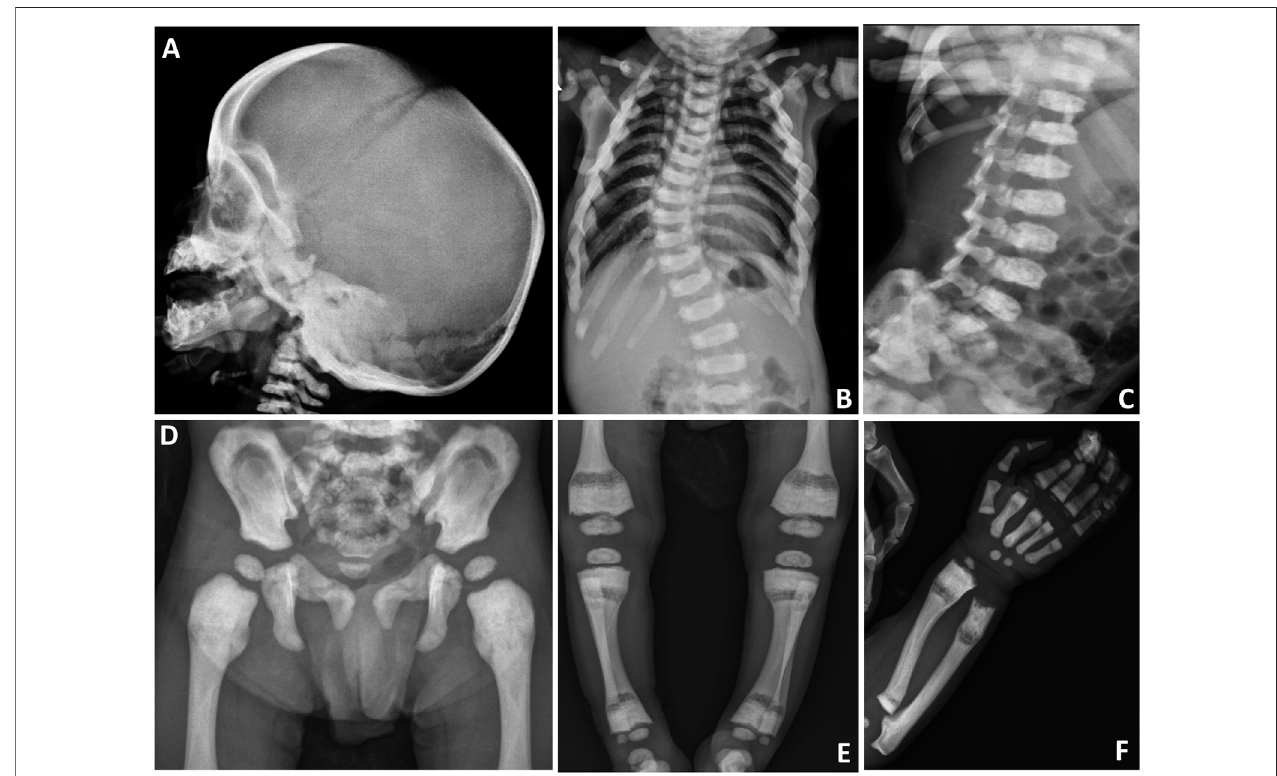
FIGURE1| Skeletalsurveyofthepatient. (A) Sclerosisofthecraniofacialbones,especiallyattheskullbase. (B) Scoliosisatthethoraciclevel. (C) Plateirregularities and mildly reduced height ofthevertebralcorpus(platyspondyly). (D) Sclerosis at the pelvic bones, especially inthe iliacbodies. (E) Radiolucency at the metadiaphyseal junctionandsclerosisattheendoflongbones. (F) Sclerosisoftheradius,ulna,metacarpalbones,andproximalphalanges.Radiolucencyatthemetadiaphysealjunction of radius and ulna is also noted.